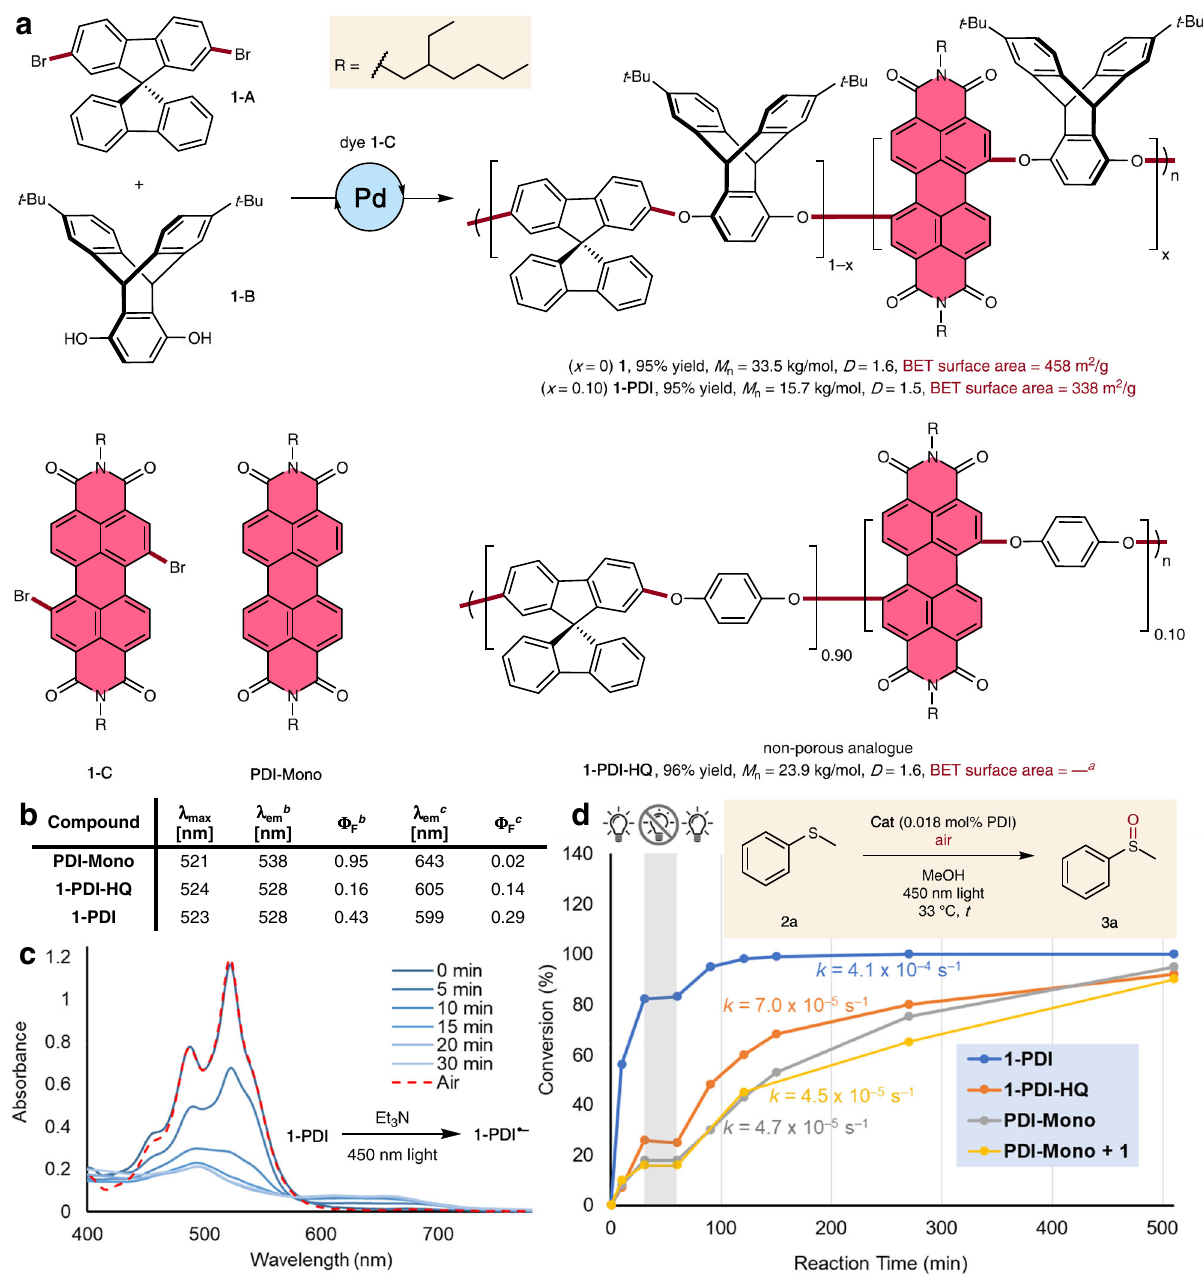
Fig. 2 Perylene diimide porous-polymer catalyst. a Synthesis of 1 , 1-PDI , and 1-PDI-HQ . See the Supplementary Information for detailed conditions. b Photophysical properties. c Light-driven reversible redox process with an amine partner. d Kinetics of catalytic photo-oxidation model reaction. BET = Brunauer – Emmett – Teller method. a Too low to be reliably determined from N 2 adsorption isotherm. b Dilute THF solution (1.0 × 10 – 5 – 5.0 × 10 – 7 M). c Solid state